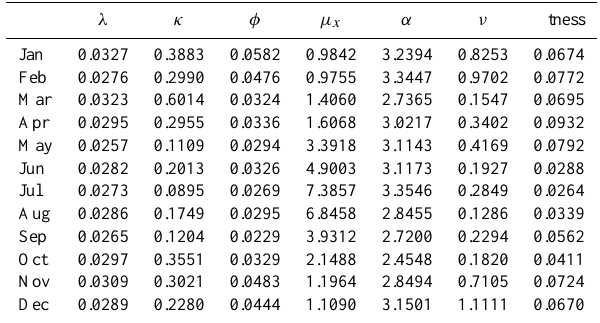
Table 6. Final parameters resulting from calibration with OF1 found by each of the optimization methods, except for the month of April for which the displayed minimum was only found by PSO.